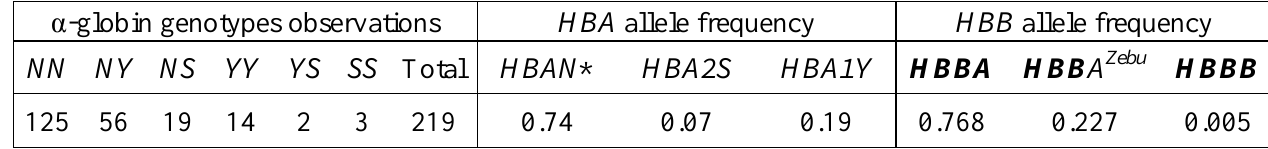
Table 6. Alpha globin genotypes observed, alpha globin haplotype frequency, and beta globin allele frequency obtained by screening the Podolic cattle